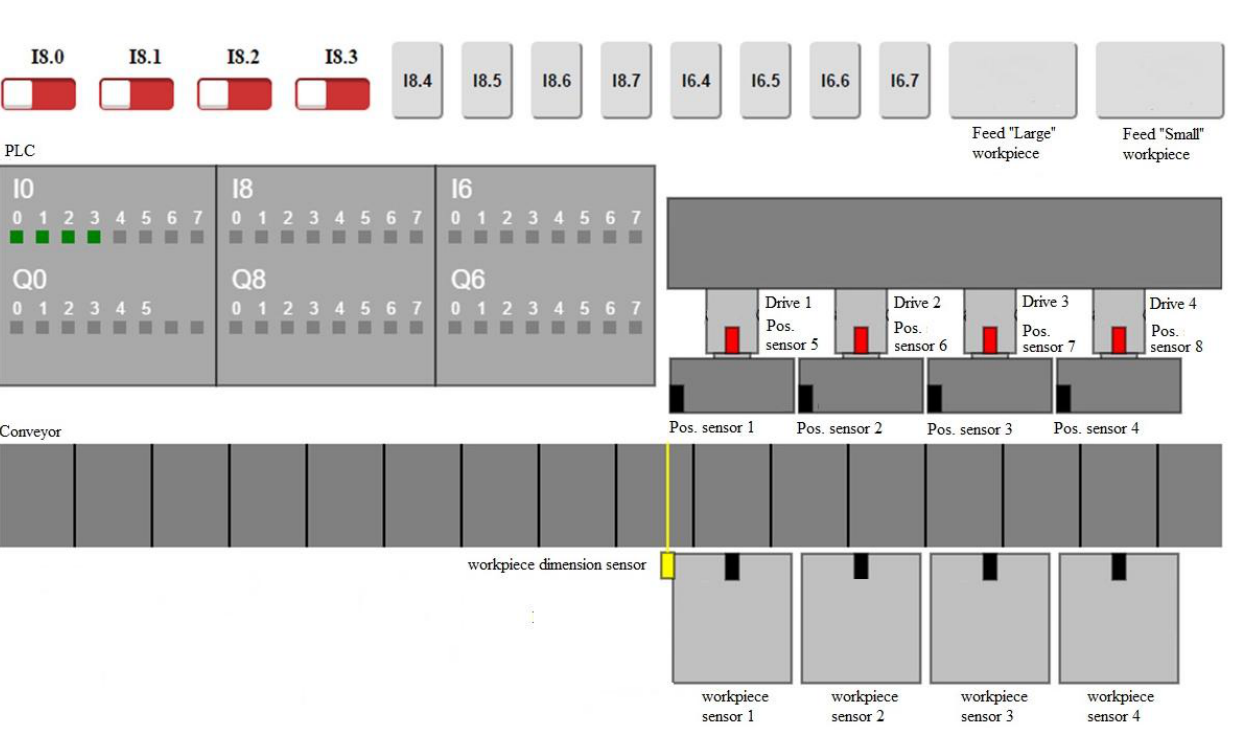
Figure 4 . Virtual lab workbench: Sorting